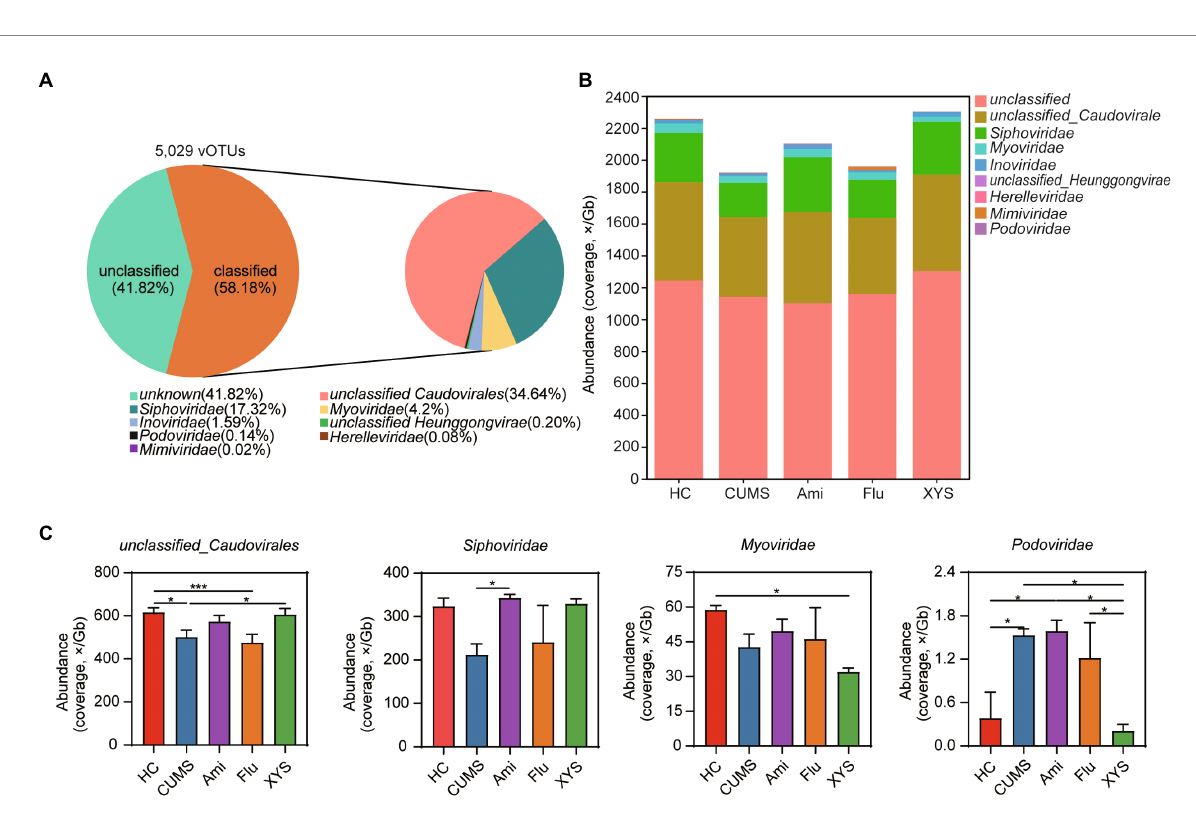
FIGURE 2 The DNA viral composition and taxa at the family levels among the five groups. (A) Community pie-chart showing the proportion of viral operational taxonomic units (vOTUs) that were assigned to viral taxa at the family level. (B) Bar plot showing the gut viral abundance of all samples at the family level. (C) Variation analysis to identify differentially present taxa between the five groups at the family levels. Significant different are indicated: * p < 0.05, ** p < 0.01, *** p <